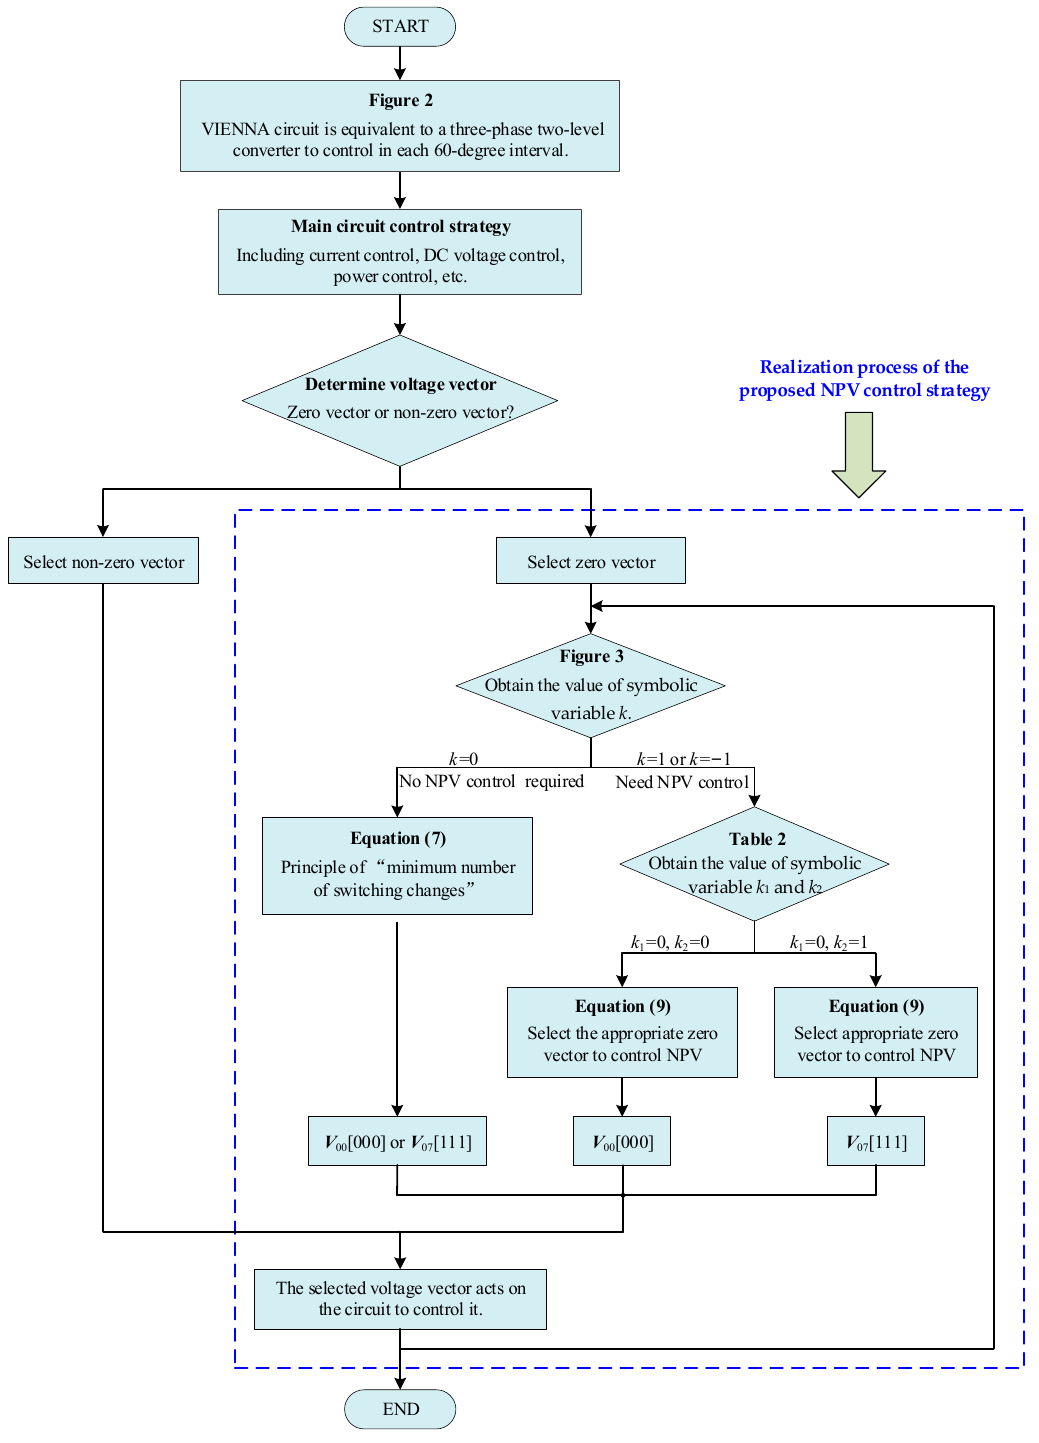
Figure 4. Control flow of VIENNA rectifier.